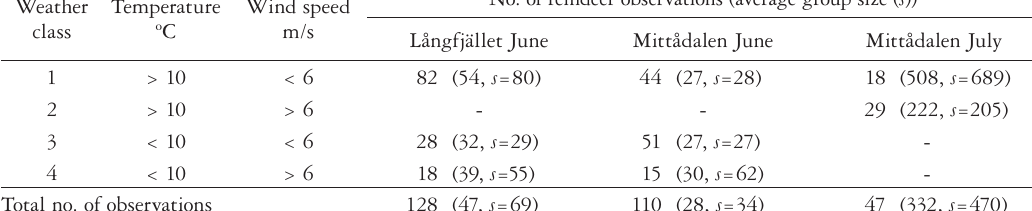
Table 2. Number of observed reindeer groups during systematic aerial observations in the two study areas, distributed over the occurring weather classes. The numbers in parenthesis are the average group sizes with standard devia- tions ( s ) based on approximate estimates of animal